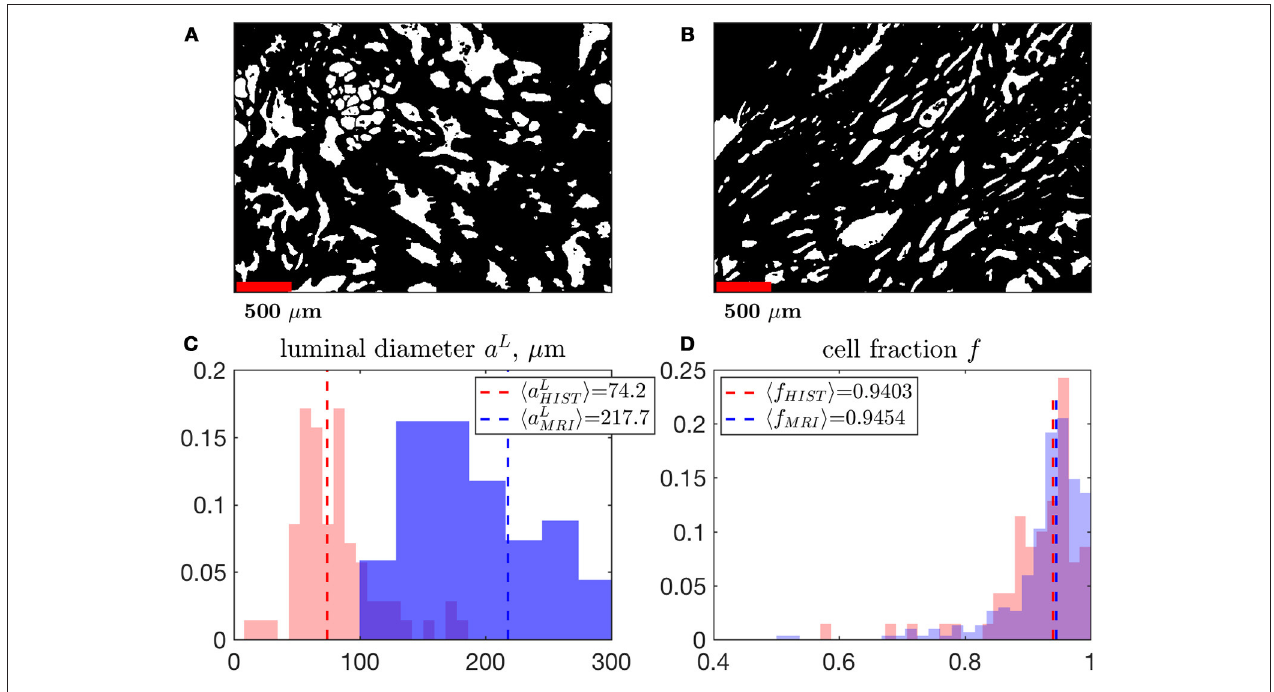
FIGURE 10 | A comparison of MRI- and histology-derived cellular fraction, f , and luminal diameter, a L . (A,B) Two samples of benign peripheral zone containing 1,000 1,400 pixels over a field of view of 2.4 3.4 mm 2 were segmented using K-means clustering. 200 200 non-overlapping pixel segments were sampled from × × × 3 L these masks in order to determine the volume fraction, Equation (13), and surface-to-volume ratio, S / V hist = 6 V / S . 2 l / A , which was then used to approximate a = The power-law exponent 3/2 was used to convert the 2-dimensional properties of histology into 3-dimensional units (in order to match the MRI results). This conversion approximately assumes a 3-dimensional cubic geometry within the luminal compartment (see section Methods). We display histograms the median of each distribution comparing a L (C) and f (D) , derived from MRI and histology. Note that the histograms for MRI results are identical to distributions shown in Figure 5C , for f MRI , Figure 9G , for a L MRI